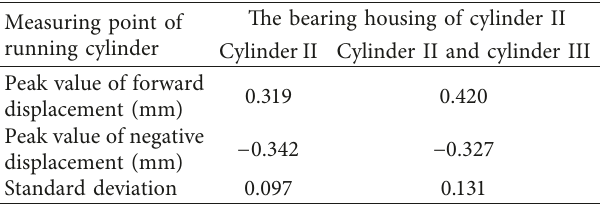
Table 6: Vertical vibration parameters of the bearing housing of cylinder